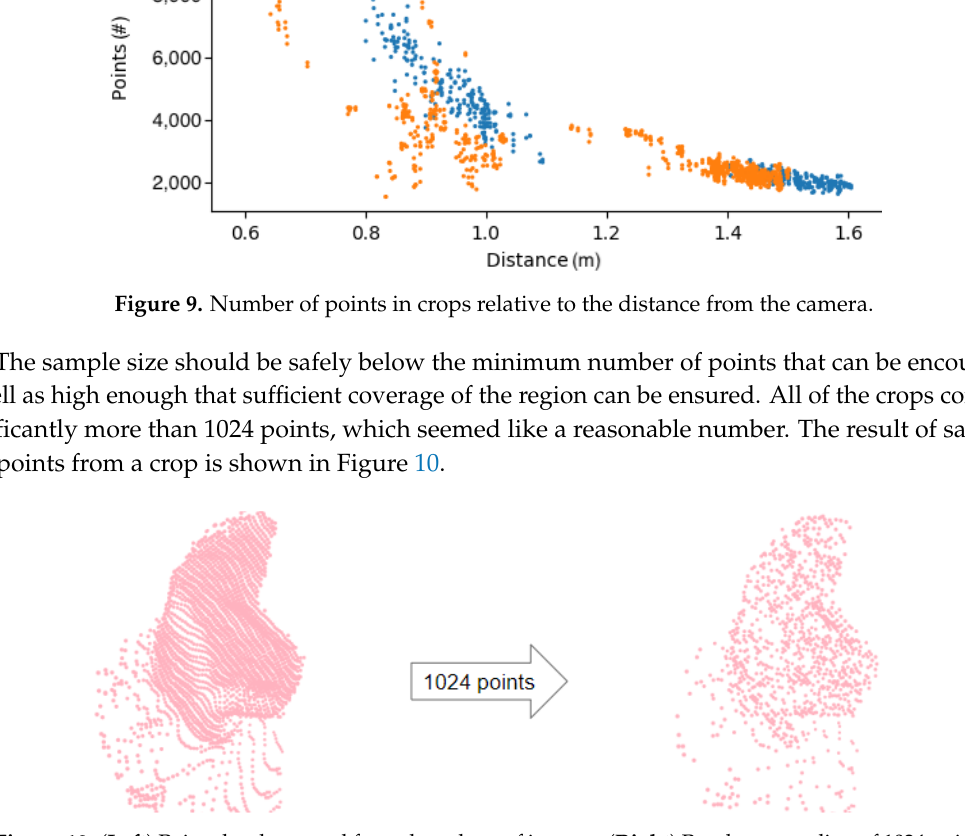
Figure 10. ( Left ) Point cloud cropped from the sphere of interest. ( Right ) Random sampling of 1024